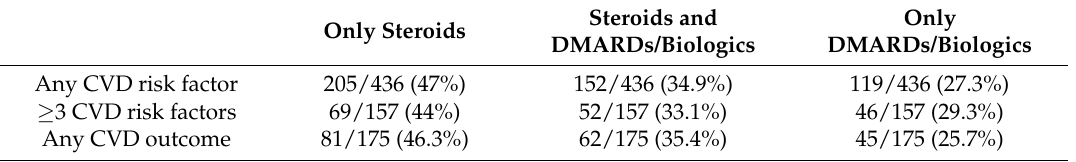
Table 5. Therapeutic regimens and associated CVD risk factors and